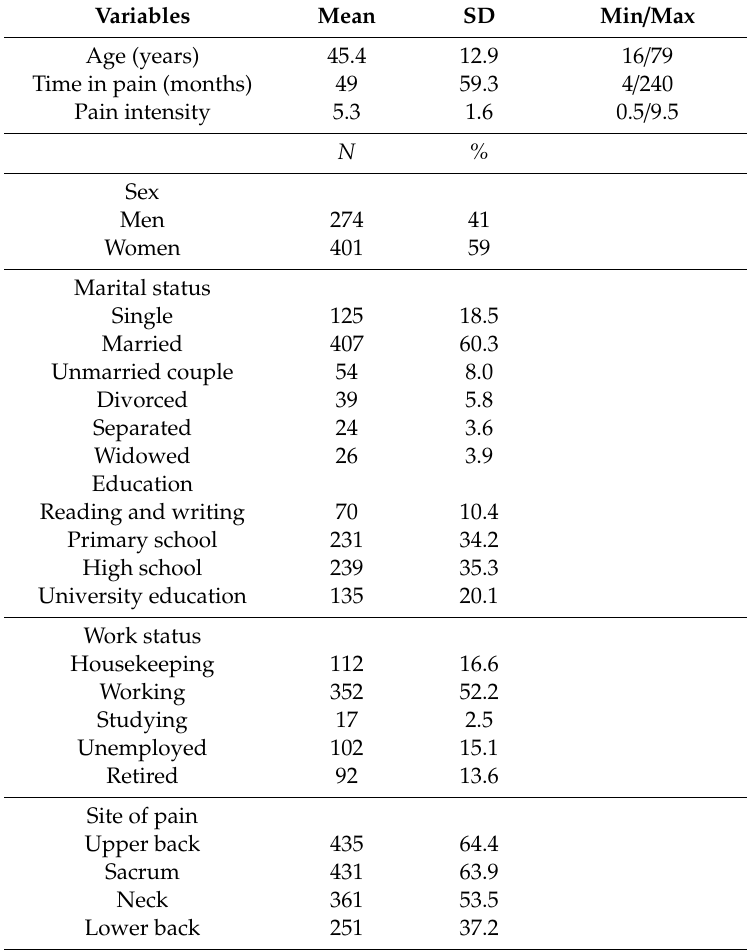
Table 1. Frequency data for the demographic and clinical variables ( N =